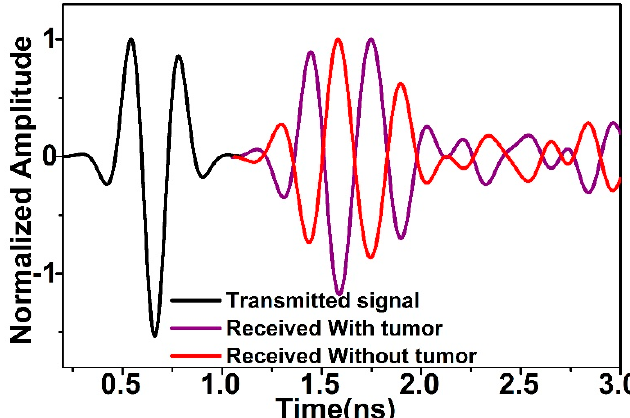
Figure 10. Normalized magnitude of the received pulse over transmitted pulse.